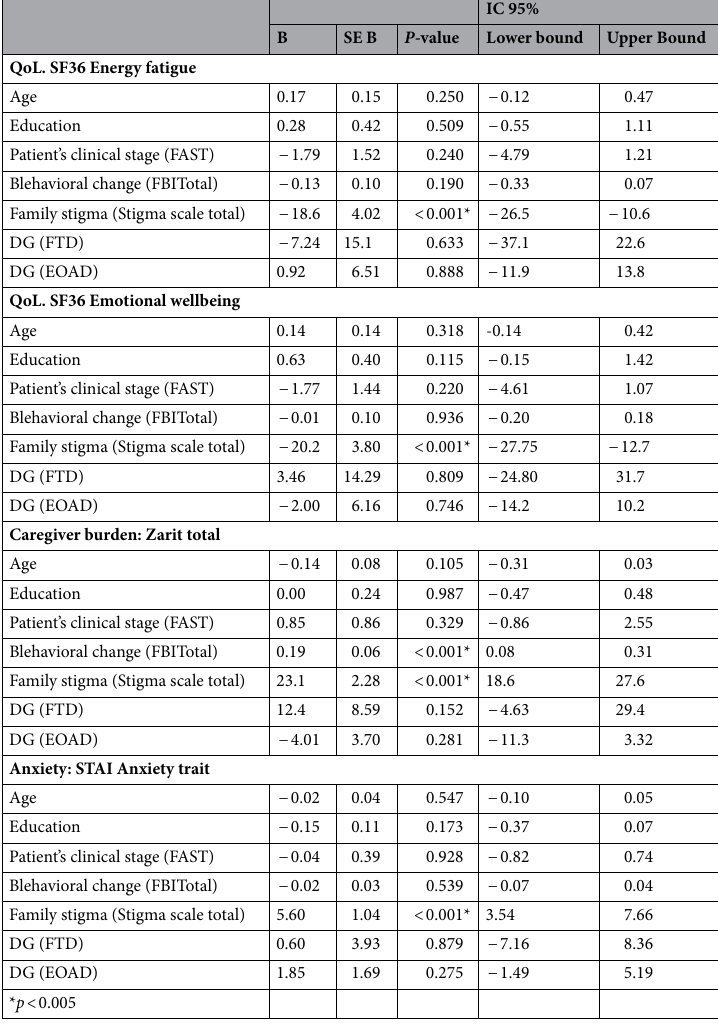
Table 3. Parameter estimates for associations among outcomes and independent